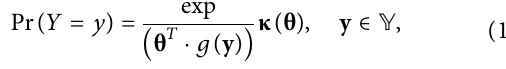
Figure 2: We use valued ERGM network models to study product competition in both the consideration stage (the network in (a)) and the choice stage (the network in (b)). The nodes represent cars as an example in these network illustrations and links represent competition